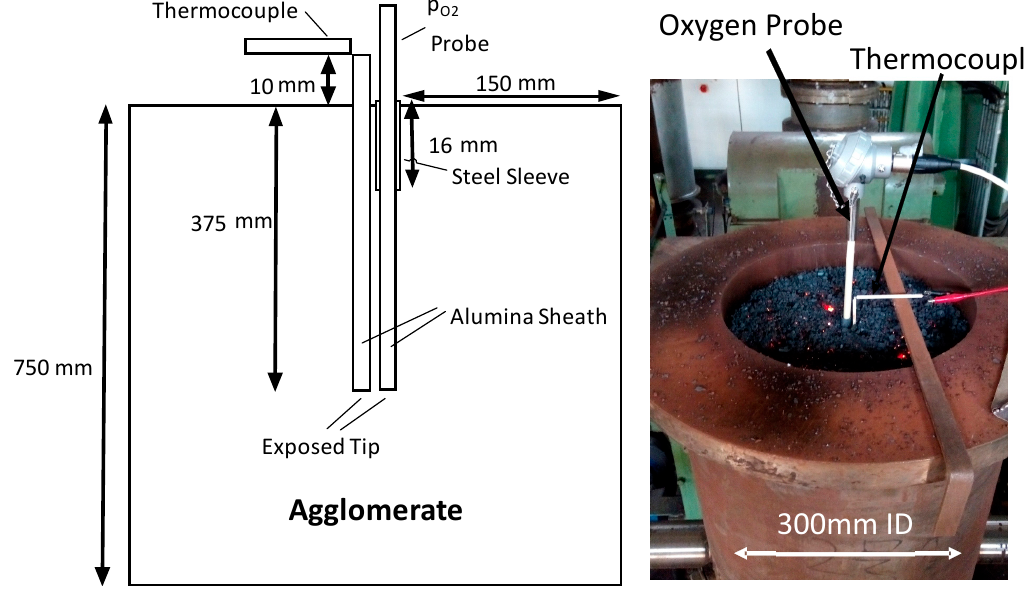
Figure 2. Schematic of the sinter pot and a schematic image showing the initial position of the thermocouple and p O2 probe within the bed.